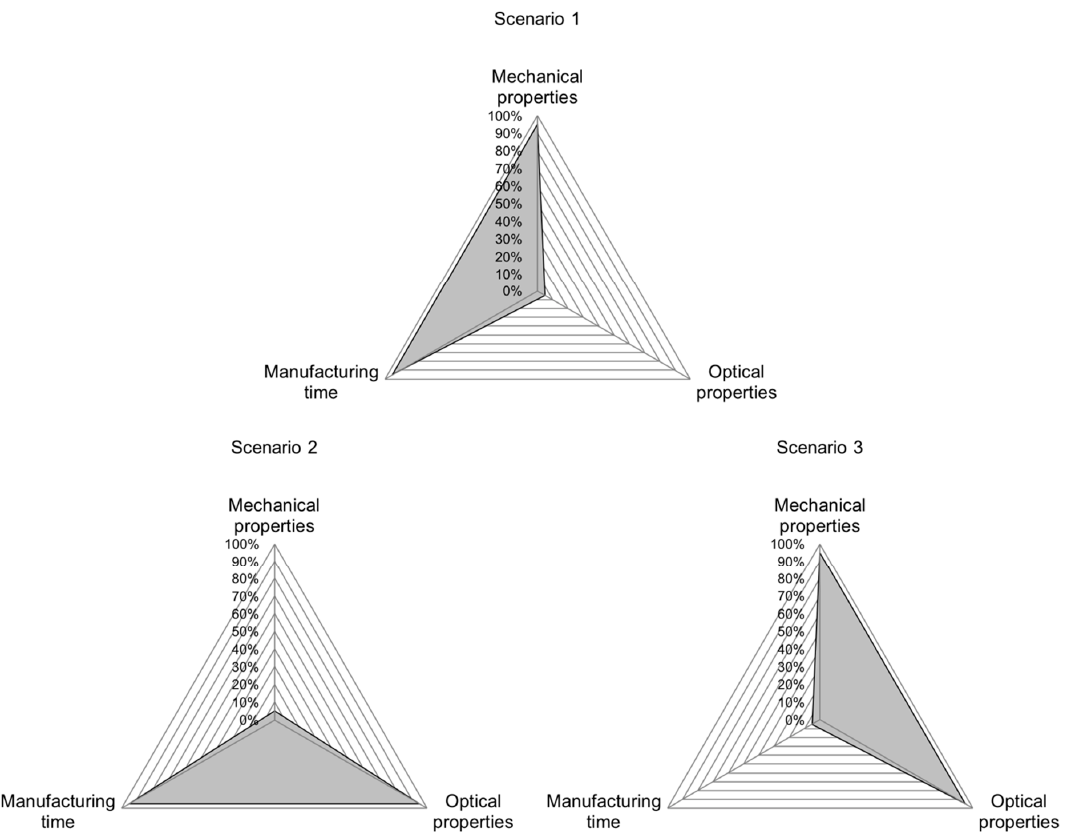
Figure 5. Scenario 1 to 3 used to validate the accuracy of the demonstrated INN. Each scenario favors two distinct part qualities while allowing a compromise in the third. The gray area shows the fulfilment of each quality category.